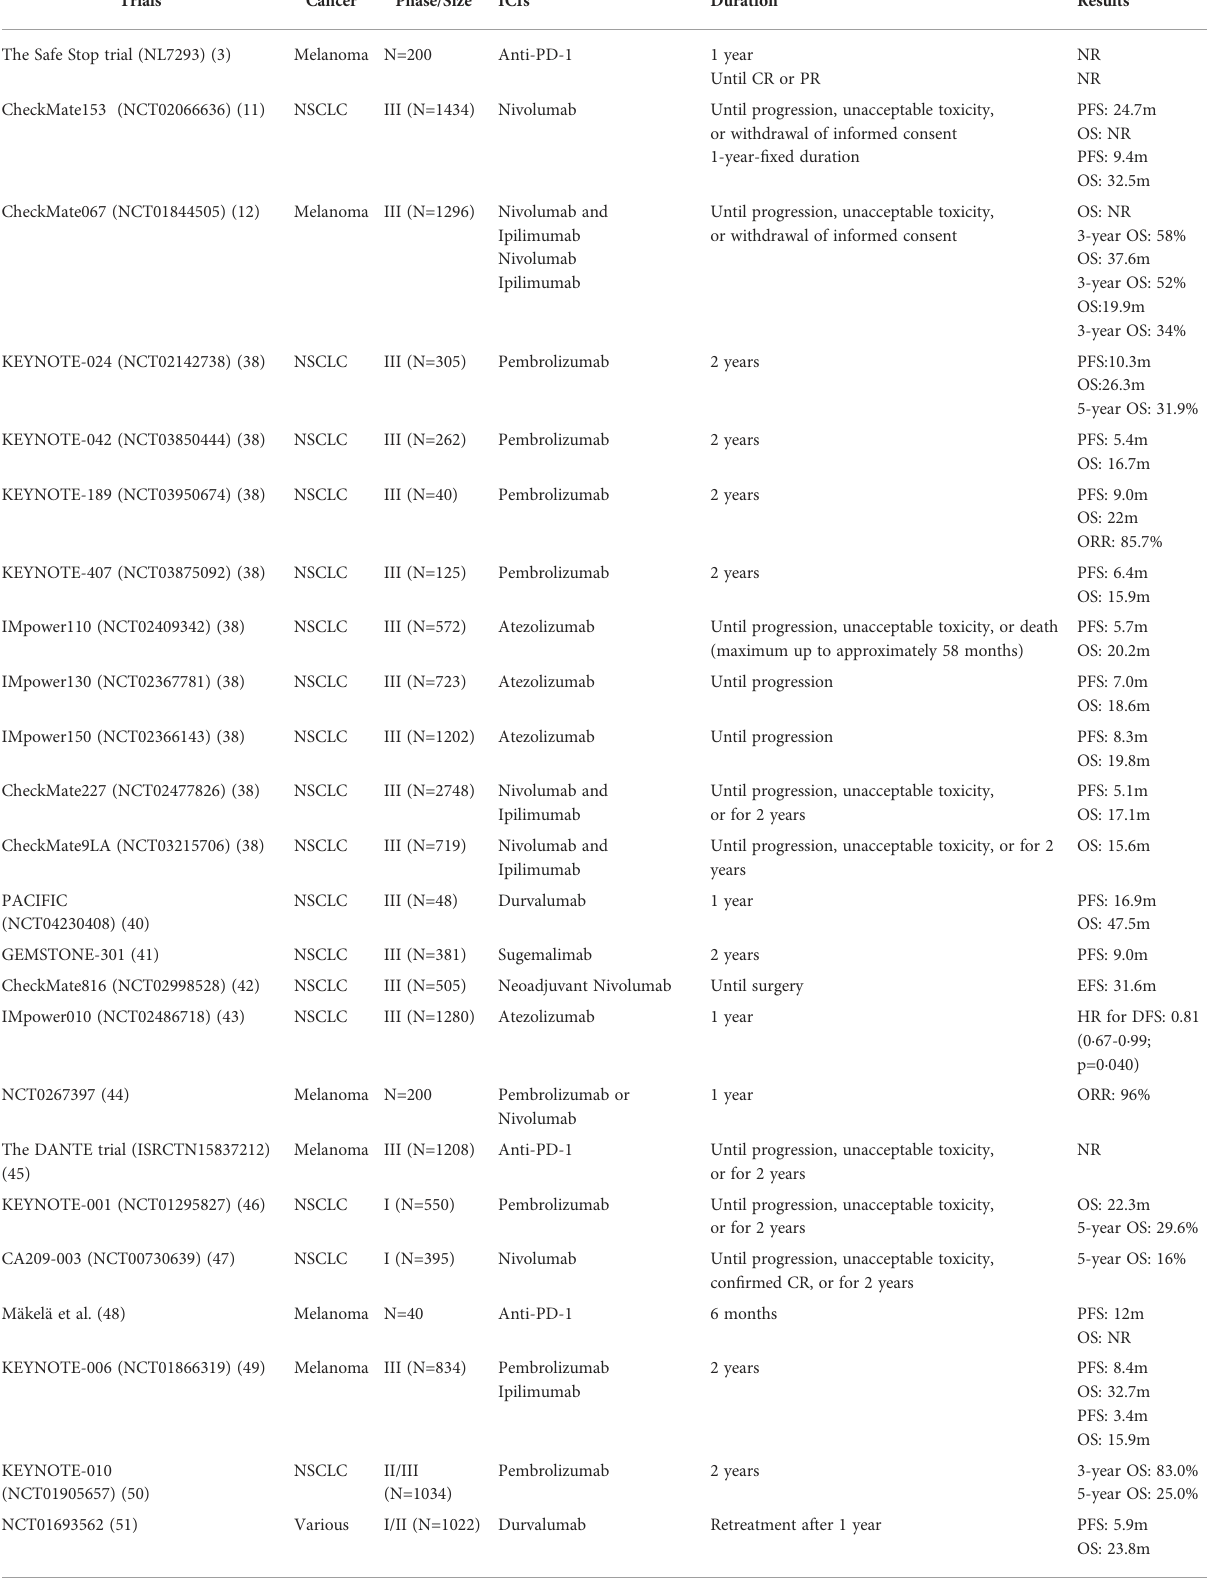
TABLE 2 Clinical trials investigating the duration of ICIs.